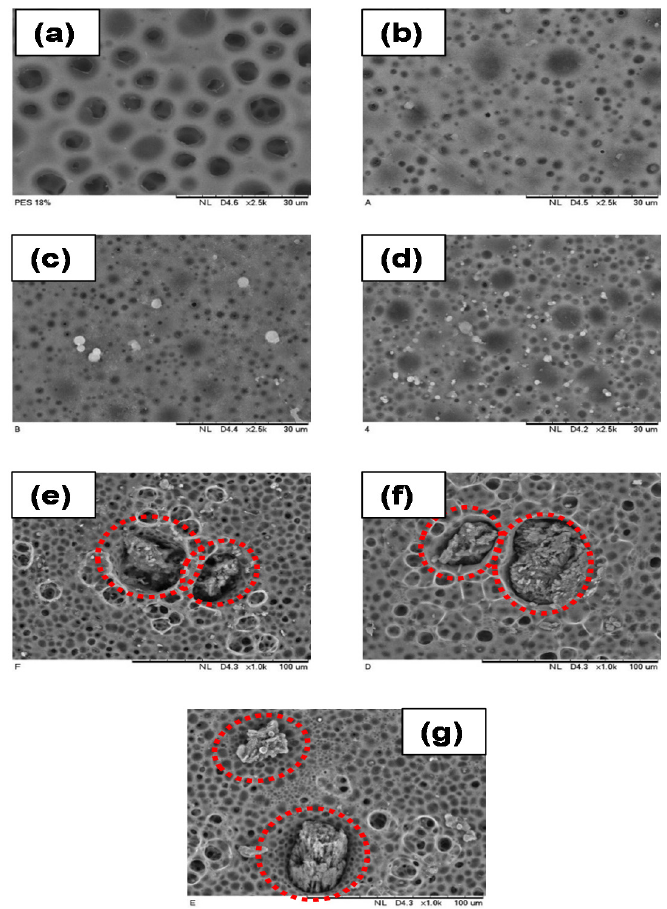
Figure 5. SEM images of top surface of PES/LSMM-OGCN membranes at 2500 × magnification: ( a ) PES18wt%; ( b ) PES/LSMM-OGCN0wt%; ( c ) PES/LSMM-OGCN0.5wt%; ( d ) PES/LSMM-OGCN1.0wt%; ( e ) PES/LSMM-OGCN1.5wt%; ( f ) PES/LSMM-OGCN2.0wt%; and ( g ) OGCN2.5wt%.